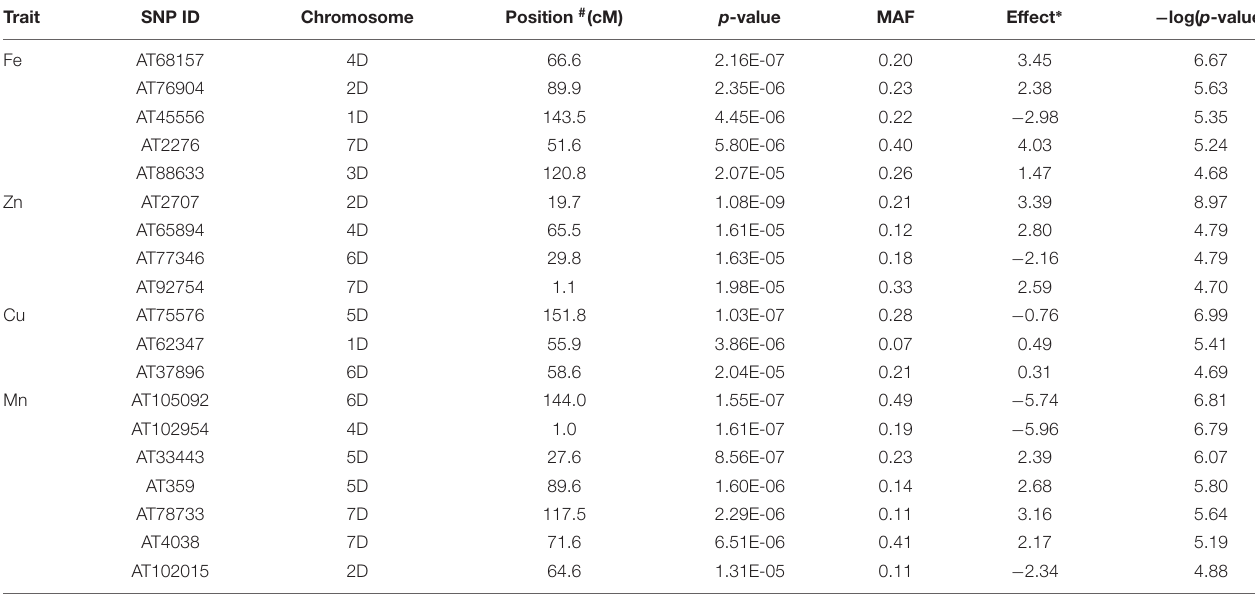
TABLE 3 | List of significant marker loci associated with BLUP values of grain micronutrient (Fe, Z, Cu, Mn) concentration. Trait SNP ID Chromosome Position # (cM) p -value MAF Effect ∗ − log( p -value)